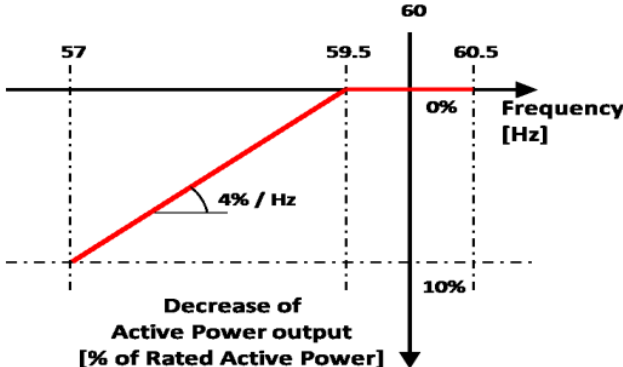
Figure 8. Maximum active power output reduction diagram.